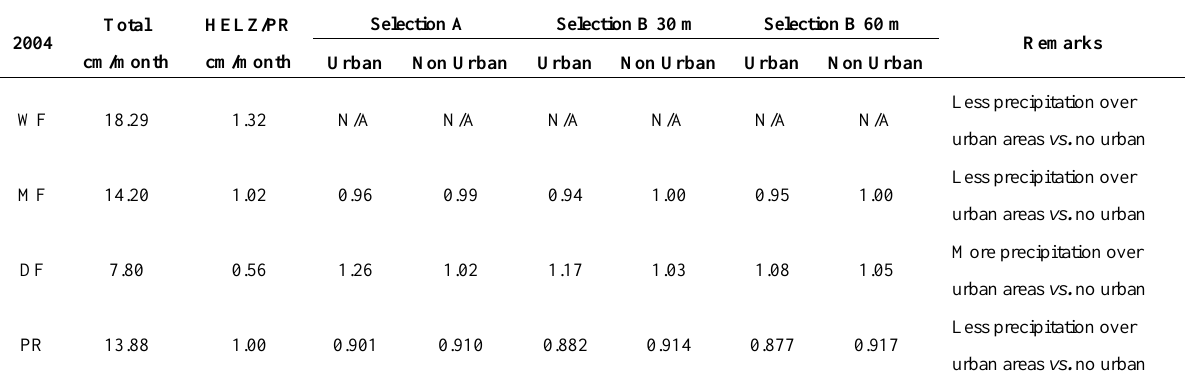
Table 7. 2004 LULC average monthly precipitation ratio